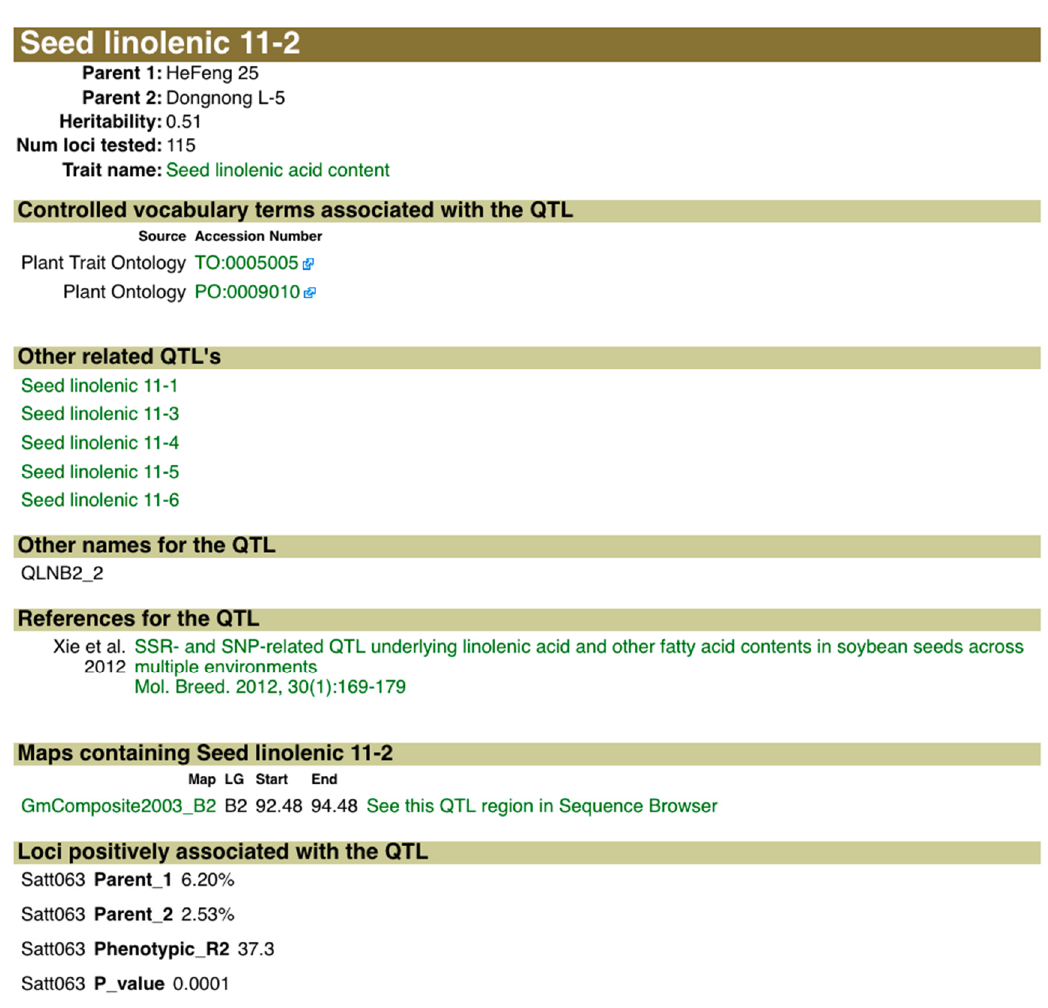
Figure 2. QTL report page for Seed linolenic 11-2. The QTL report for Seed linolenic 11-2 provides details on the QTL such as its heritability, parents and parental phenotype. It also lists any other phenotypes measured in the study (none in this example) and other QTLs for the trait identified in the study (Other Related QTLs). The map and location of the QTL is presented in the section “Maps containing Seed linolenic 11-2”. Clicking on the link “See this QTL region in Sequence Browser” will take the user to the sequence browser view of the approximate QTL on the sequence map to allow browsing of the gene model annotations. Genetic loci that are associated with the QTL are listed in the “Loci positively associated with the QTL” section along with association values for the loci.